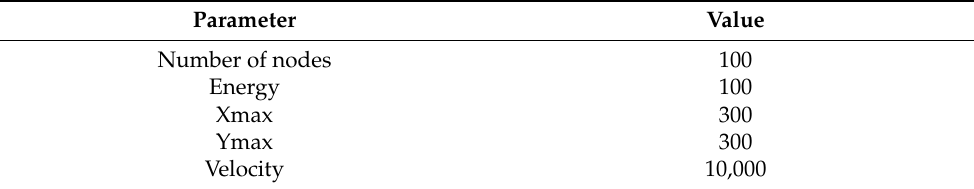
Table 1. Simulation parameters.